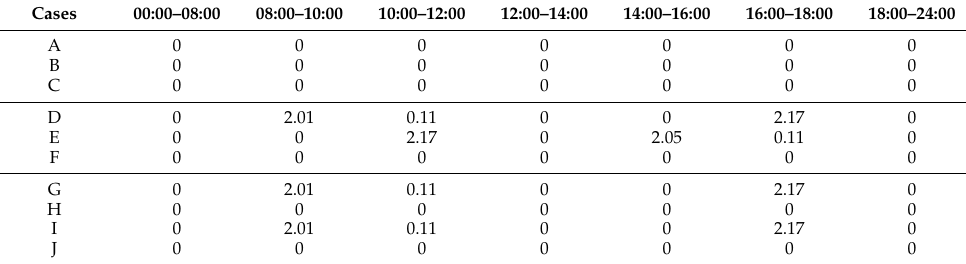
Table 3. Air quality uncomfortable hours in each case studied.